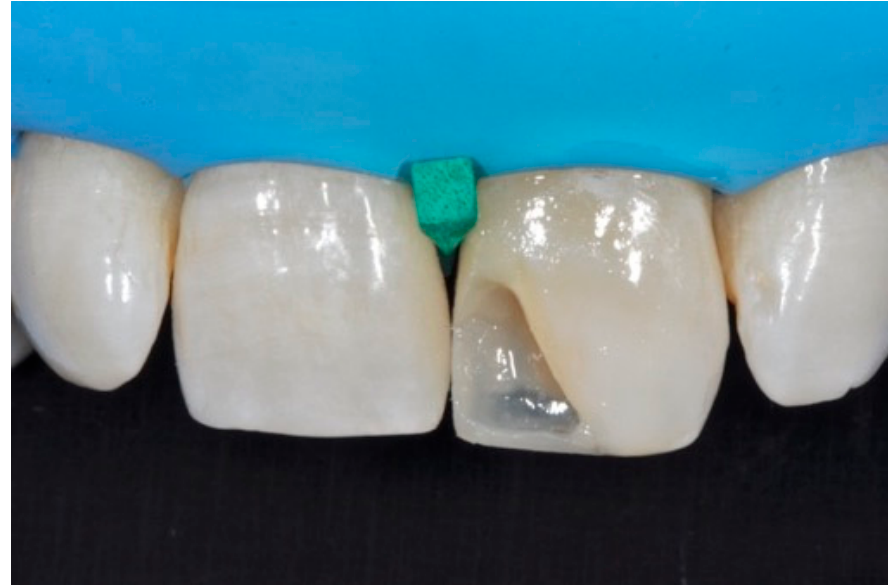
Figure 44. The frame modified either in the incisal frame and in the interproximal wall.